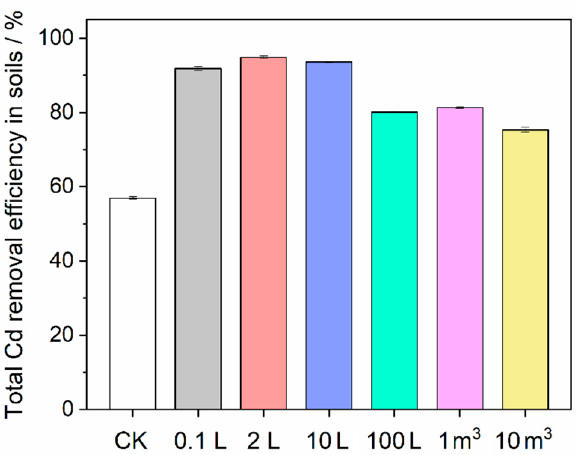
Figure 1. Total Cd removal efficiency in soils using the mixotrophic acidophiles in different scale-up cultivation stages. Table 3. Pearson correlation analysis between soil Cd removal and solution environmental factors, including pH, MD (microbial density), ESL (elevated sulfate radical level), and RGL (reduced glu- cose level).